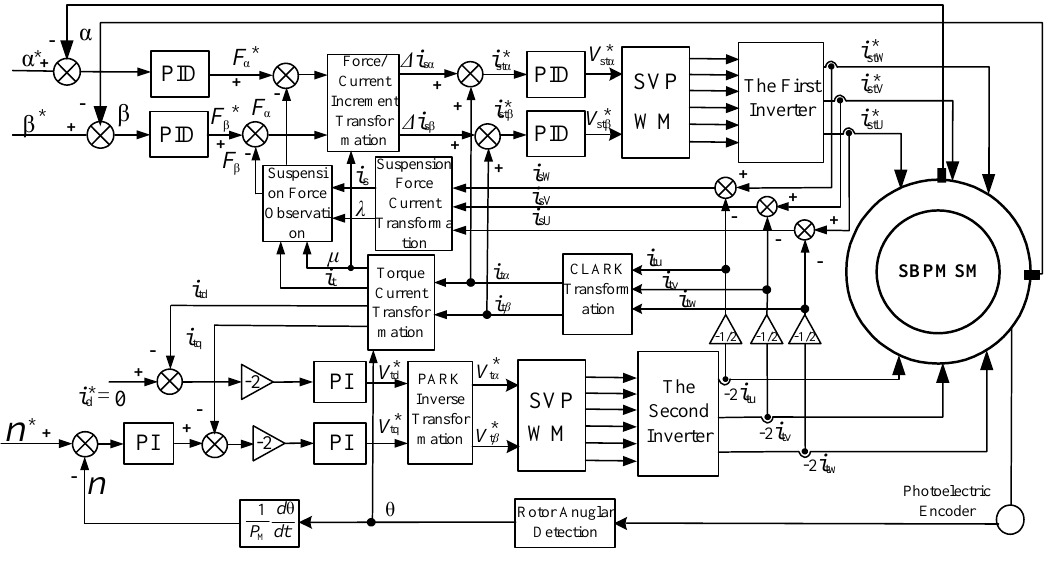
Figure 11. DCLVC block diagram of SBPMSM.